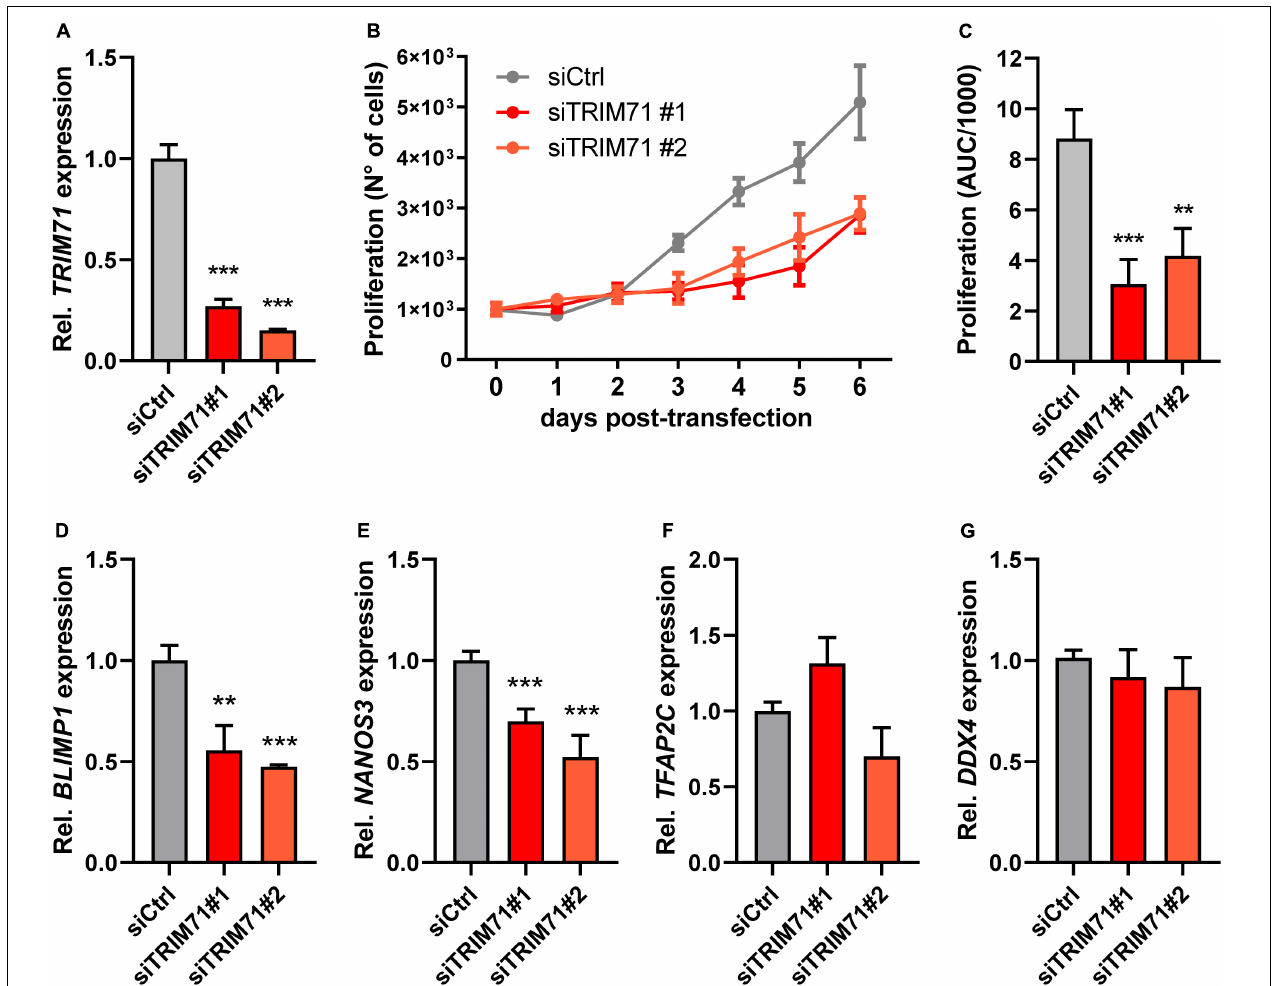
FIGURE 4 | TRIM71 controls proliferation in the in vitro PGC-like model cell line TCam-2. (A) RT-qPCR measurement of TRIM71 in wild type (siCtrl) and TRIM71 KD (siTRIM71 #1 and siTRIM71 #2) TCam-2 cells 72 h post-transfection ( n = 3). (B) Proliferation of wild type (siCtrl) and TRIM71 KD (siTRIM71 #1 and siTRIM71 #2) TCam-2 cells depicting the increase in cell numbers over time after transfecting them with siRNAs and seeding them in equal numbers (d0) ( n = 5). (C) Area under curve (AUC) measurements for the proliferation curves depicted in B ( n = 5). (D–G) RT-qPCR measurements for the indicated PGC markers in wild type (siCtrl) and TRIM71 knockdown (siTRIM71 #1 and siTRIM71 #2) TCam-2 cells 72 h post-transfection ( n =3–6). For all RT-qPCRs, the housekeeping gene 18S rRNA was used for normalization. For all graphs, error bars represent the SEM. *** P -value < 0.005, ** P -value < 0.01 (unpaired Student’s t -test). See also Supplementary Figure 8